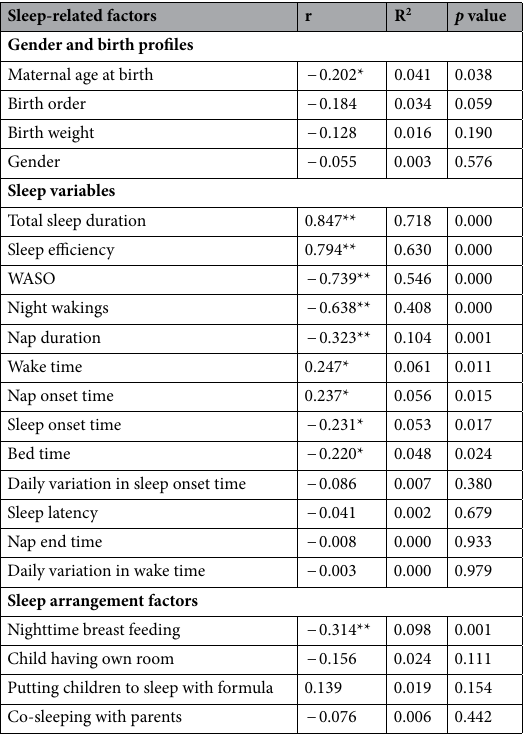
Table 4. The associations of gender/birth profiles, sleep variables, and sleep arrangement factors and nighttime sleep duration evaluated by univariate analysis (** p < 0.01, * p < 0.05).